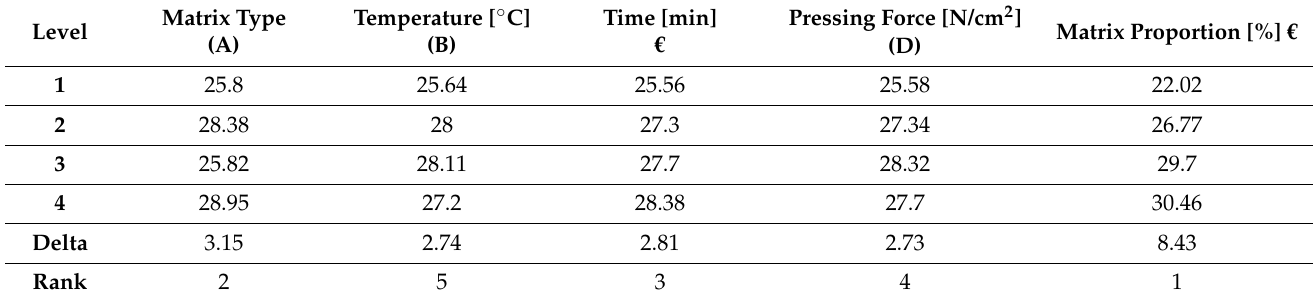
Table 6. Classification of influence